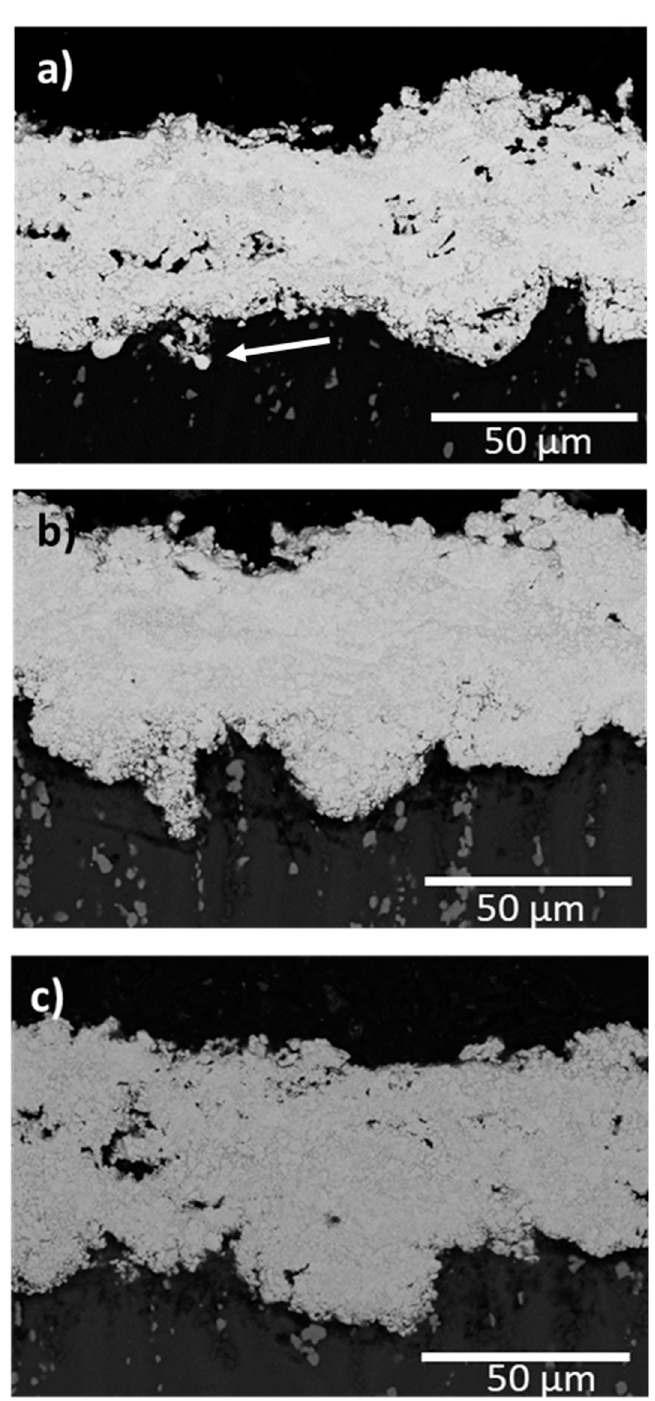
Figure 5. SEM micrographs of the cross section of ( a ) 2L-2, ( b ) 2L-3, and ( c ) 2L-4.